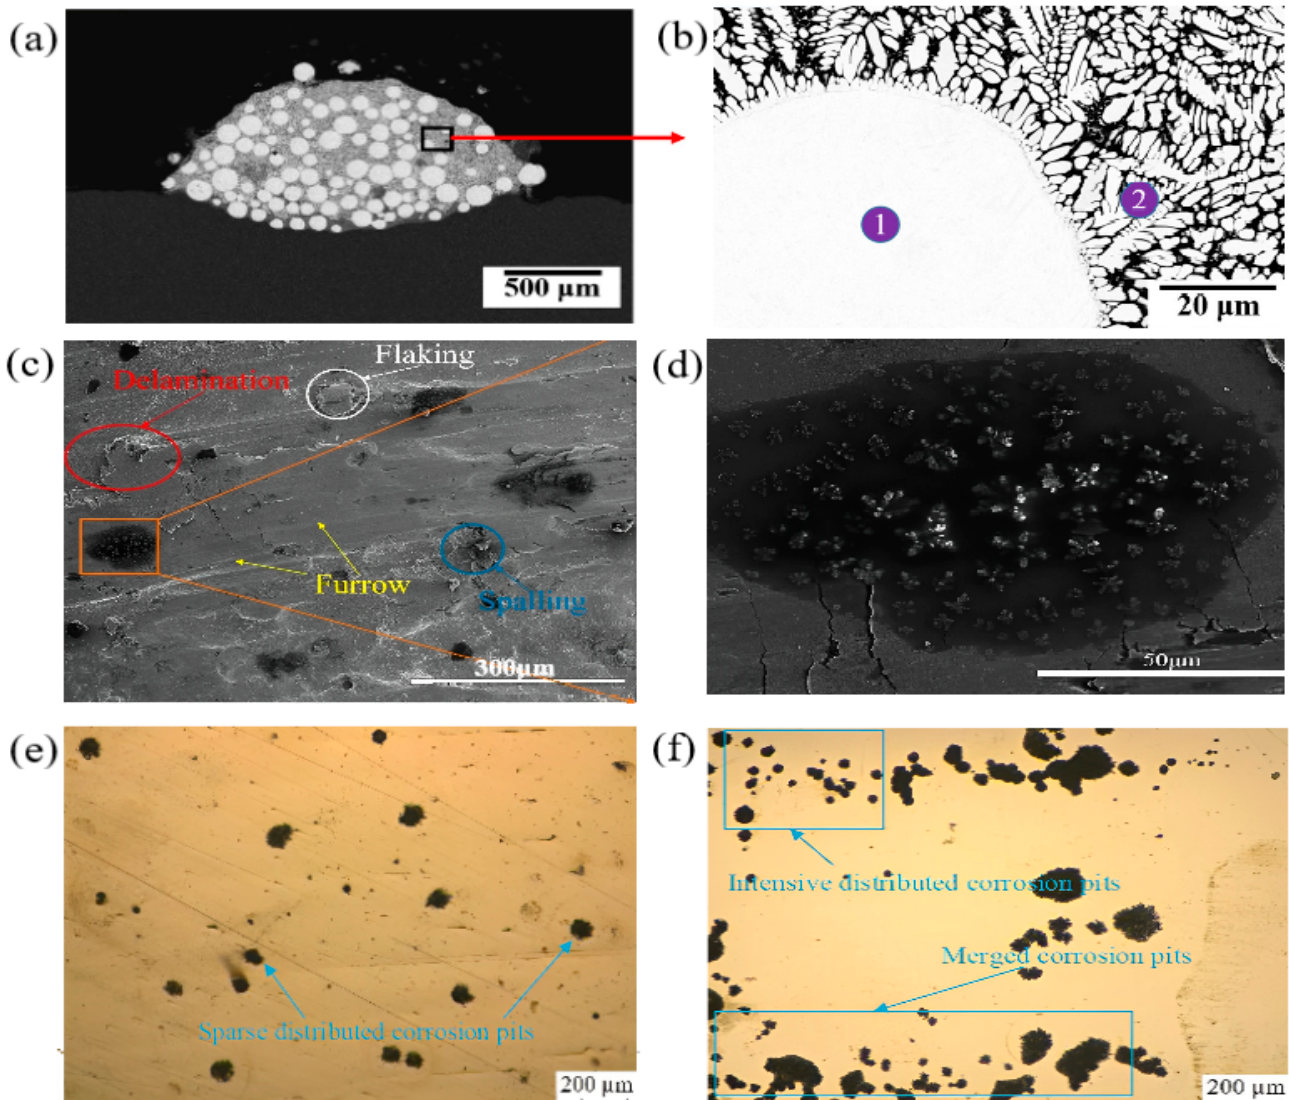
Figure 10. Microstructure of the cladding layer under optimal parameters, frictional wear properties, and corrosion resistance. ( a ) BSD image of the clad cross-section with optimal parameters. Reprinted with permission from Ref. [150]. 2021, Elsevier. ( b ) Microstructure of the cladding section with optimal parameters. 1 and 2 are showing spots for further EDS analysis. Reprinted with permission from Ref. [150]. 2021, Elsevier. ( c ) SEM image of the worn surface of a 15-5PH cladding layer under high magnification [151]. ( d ) SEM image of the worn surface of a 15-5PH cladding layer under low magnification [151]. ( e ) SEM image of 15-5PH cladding layer after electrochemical corrosion experiments [151]. ( f ) SEM image of 20Cr13 substrate after electrochemical corrosion experiments [151].